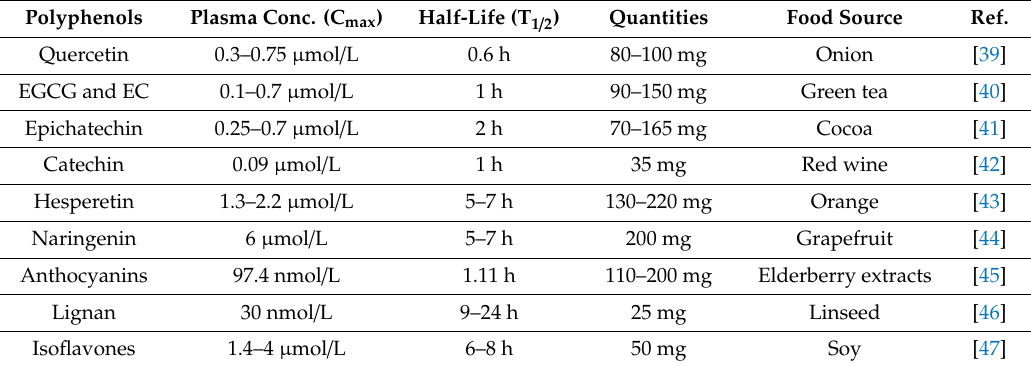
Table 1. Bioavailability of polyphenols in human plasma. EGCG—epigallocatechins Gallate; EC—epicatechins;